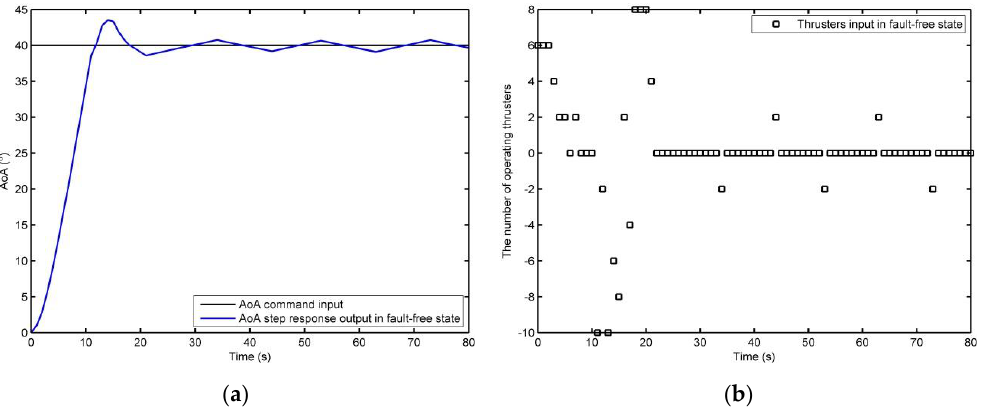
Figure 12. Angle of attack (AoA) reference response curve and the number of working thrusters in the fault-free state: ( a ) An AoA reference response curve in the fault-free state; ( b ) the number of working thrusters in the fault-free state.